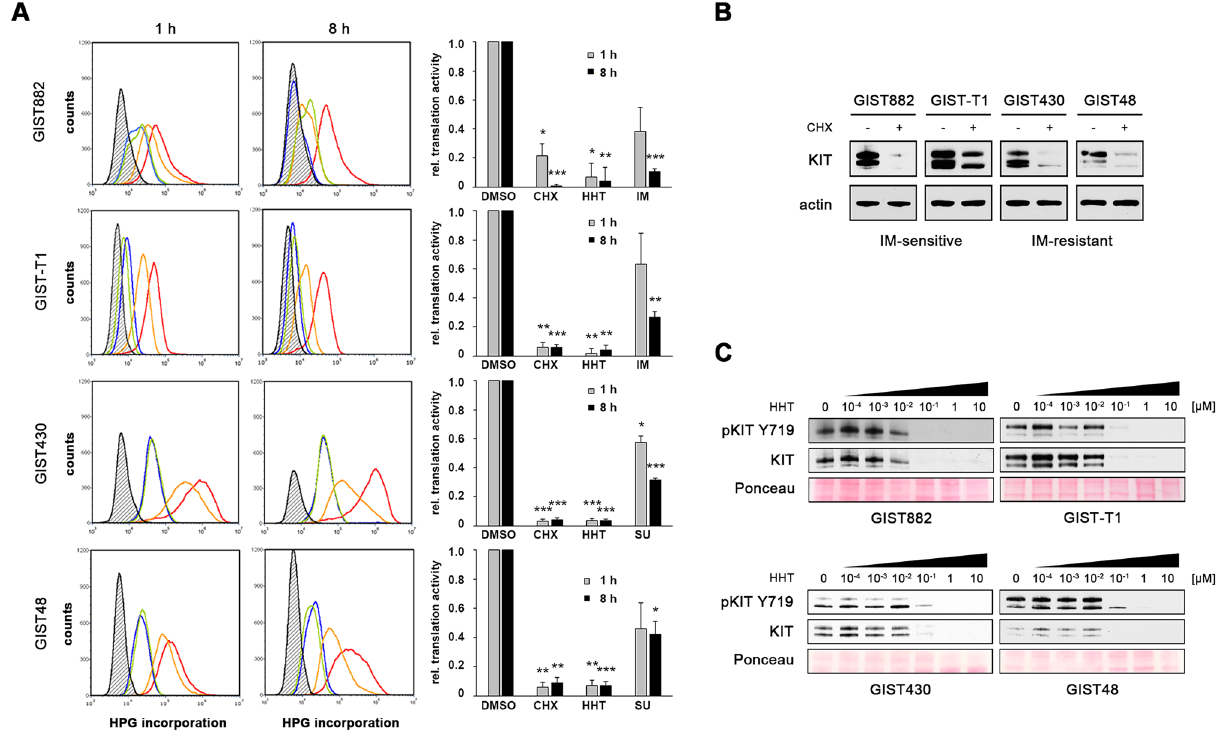
Figure 1. Homoharringtonine inhibits nascent protein synthesis and reduces KIT protein expression in GIST cells. (A) Nascent protein synthesis of GIST cells treated with homoharringtonine (HHT, 0.1 μM; green), cycloheximide (CHX, 100 μg/ml; blue), KIT inhibitor (imatinib [IM] 1 μM for GIST882 and GIST-T1; sunitinib [SU] 1 μM for GIST430 and GIST48; orange) or 0.1% DMSO control (red) for 1 h or 8 h. Cells were labelled with HPG during the last 30 min of drug treatment and incorporated cellular HPG linked to azide-modified Alexa488 was quantitated by flow cytometry. Unstained control cells are shown in black in the histogram. A change in nascent protein synthesis is indicated as a relative mean fluorescence value to the DMSO control in the bar graphs. Columns, mean + SE; *, p < 0.05 in comparison to DMSO control; **, p < 0.01 in comparison to control; ***, p < 0.001 in comparison to control (Student’s t-test, 2-tailed). (B) Immunoblot analysis for KIT protein expression of IM-sensitive (GIST882, GIST-T1) and IM-resistant (GIST430, GIST48) GIST cells after treatment with the protein translation inhibitor cycloheximide (CHX; 30 μg/ml for 3 h). (C) Immunoblotting for KIT protein expression in IM-sensitive and IM-resistant GIST cells after treatment with HHT for 72 h at the indicated concentrations. (B,C) Grouped immunoblot images are either cropped from different parts of the same gel or from a separate gel run with another aliquot of the same protein